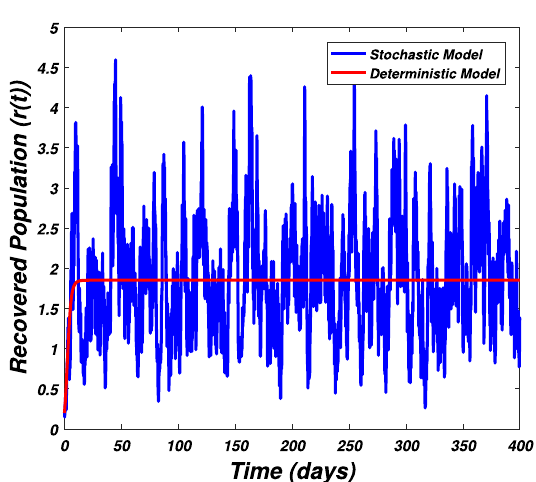
Figure 12. The graph visualizes the time dynamics of the model (1) on large scale for recovered population ( r ( t )) against the parametric value of S 2 and (0.5, 0.3, 0.2, 0.1) initial